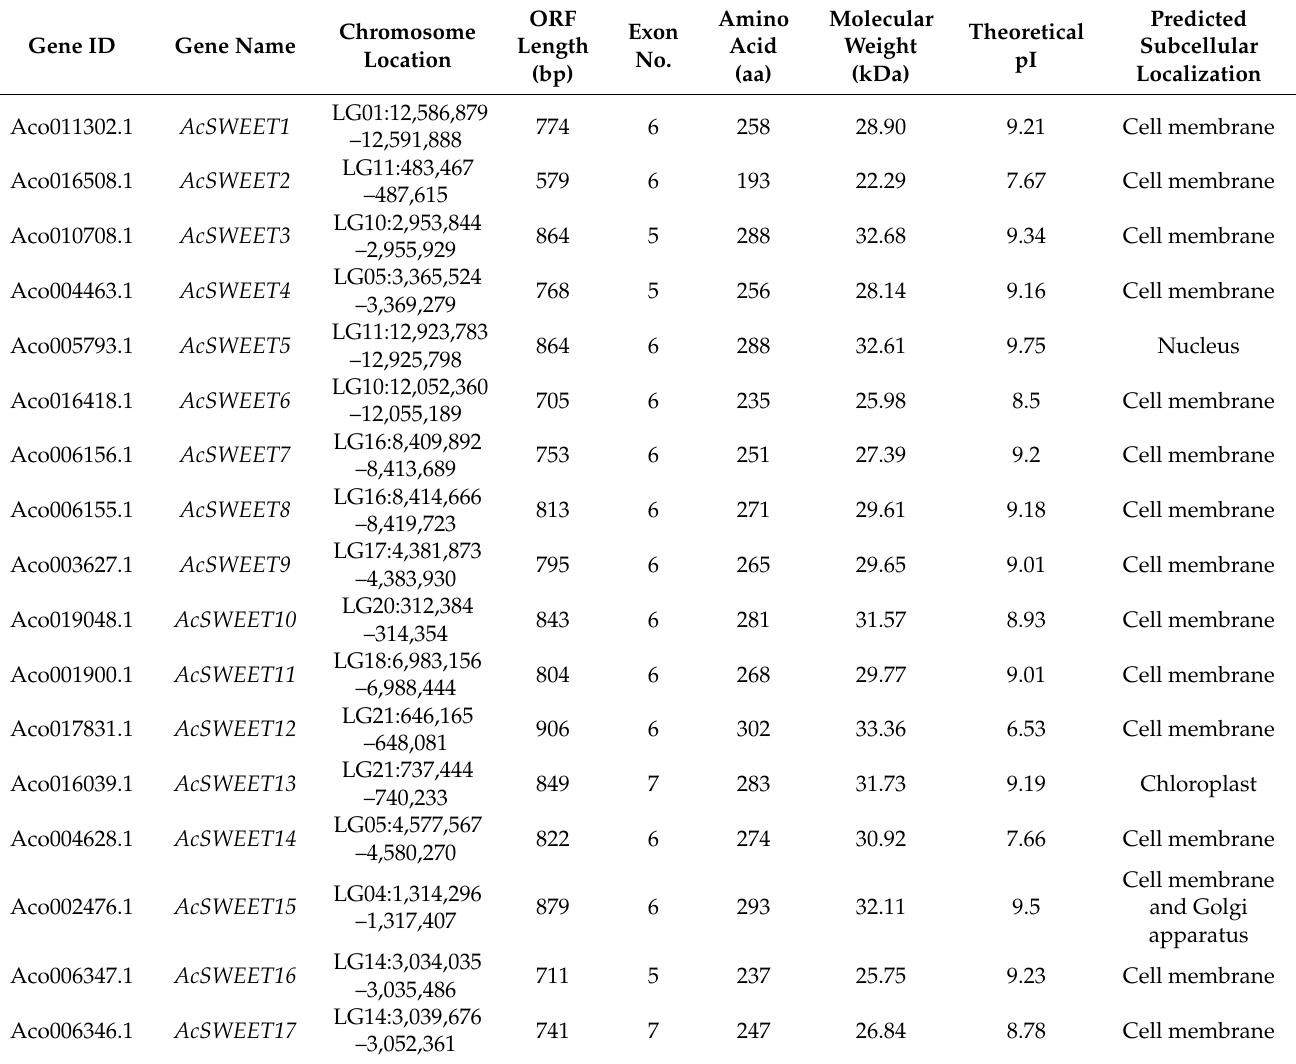
Table 1. Overview of AcSWEET genes identified in